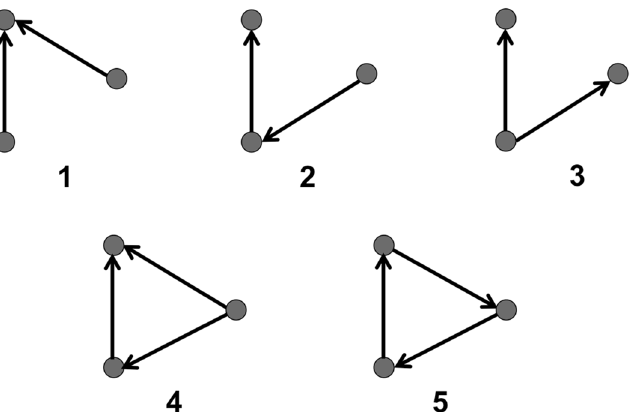
Figure 2. Possible unidirectional 3-node network motifs. A 3-node motif represents a specific pattern of interconnection between three electrodes Five 3-node motifs can exist when unidirectional connections are assessed. These five 3-node motifs are assessed in this study. Dark circles represent nodes (i.e. individual electrodes), while black lines represent the edges linking the nodes. Arrows indicate the direction of phase-lead relationship.